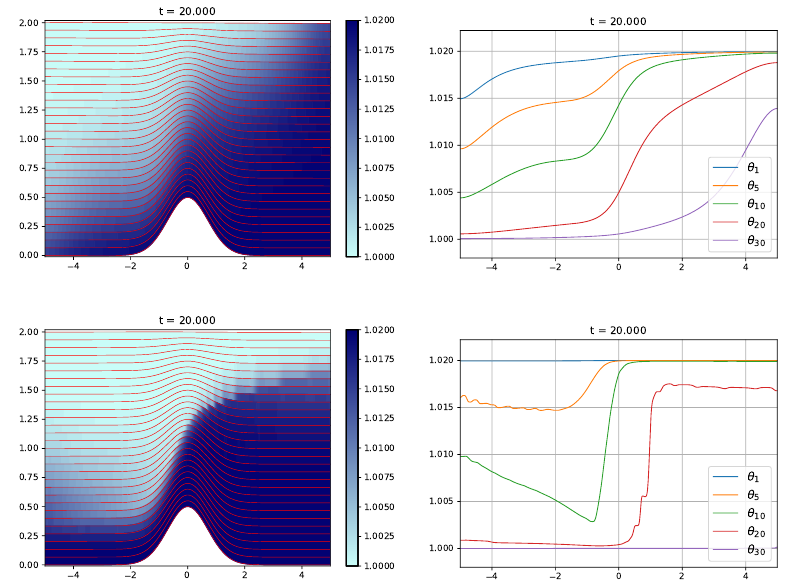
Figure 31. Distribution of the relative density θ . The first row corresponds to the first order scheme and the second row to the second order scheme.